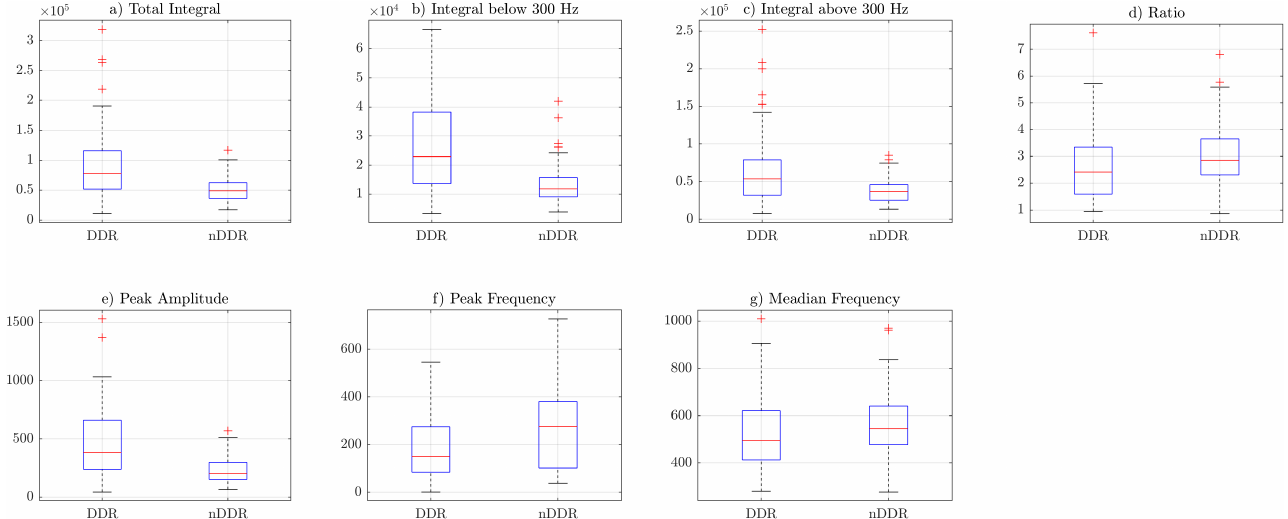
Figure 3. Box plots of raw features: ( a ) TI feature, ( b ) IB3 feature, ( c ) IA3 feature, ( d ) IBAR feature, ( e ) PA feature, ( f ) PF feature, ( g ) MF feature.